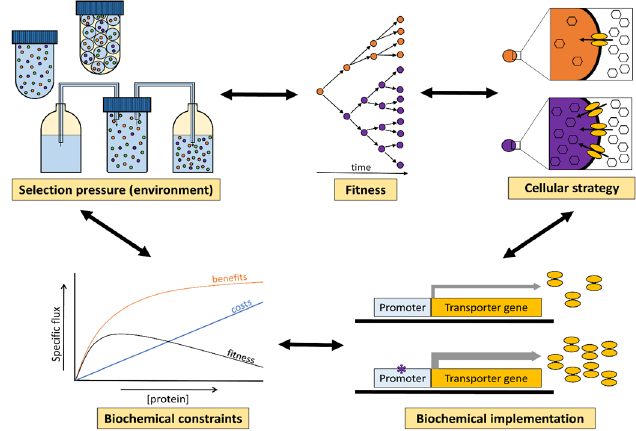
Figure 2. In evolution, the selection pressure that an organism is exposed to is set by its environment (e.g., culturing method; available substrates; presence of competitors). Fitness is defined as the ability to reproduce and/or survive in a certain environment. Different cellular strategies might increase the fitness of an organism, for example by increasing the substrate uptake rate. Cellular strategies have a biochemical basis. Adaptive changes in the biochemistry of a cell, due to a mutation, are constrained. Too high expression levels, for instance, eventually lead to a decrease in fitness when the benefits of protein production no longer outweigh its costs. There is interaction in both directions between these levels, as on the one hand a change in the environment can be a driving force for cellular adaptation through mutation and selection, but on the other hand a change in cellular strategy might change the environment (e.g., by producing metabolic by-product like